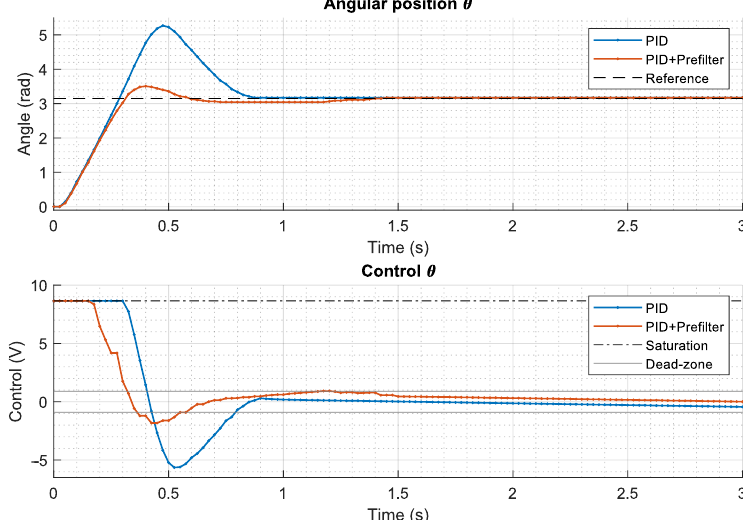
Figure 16. Back-right wheel experimental results with and without prefilter.